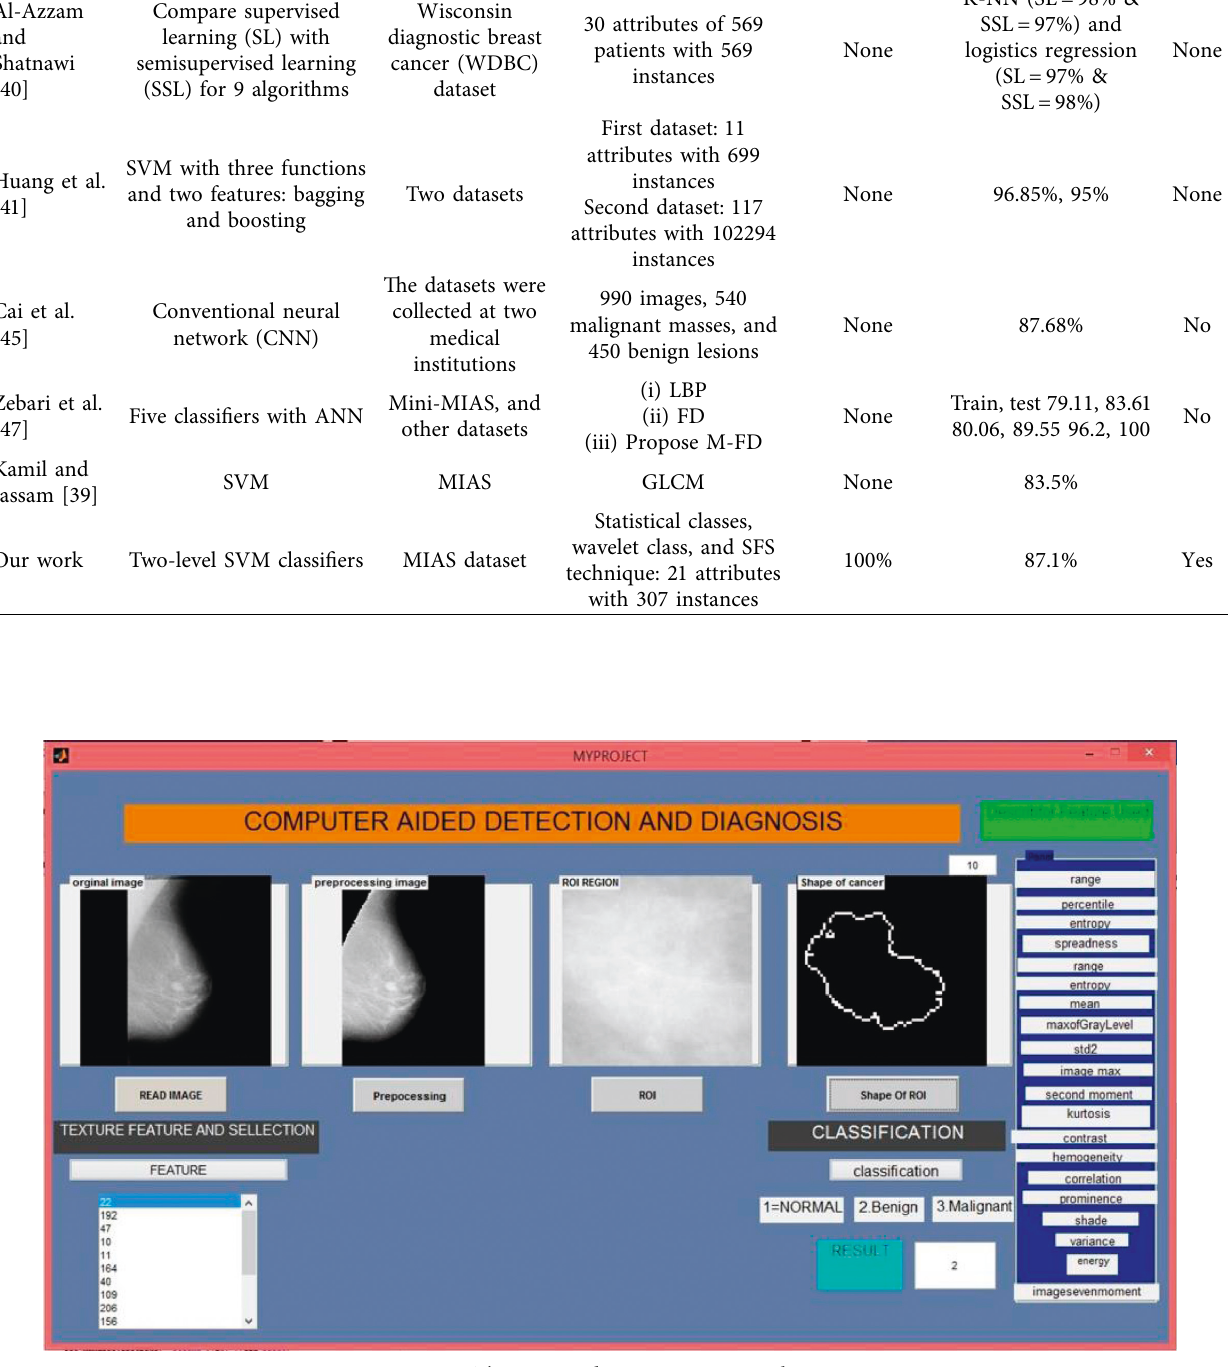
Figure 13: The proposed CADD system application.